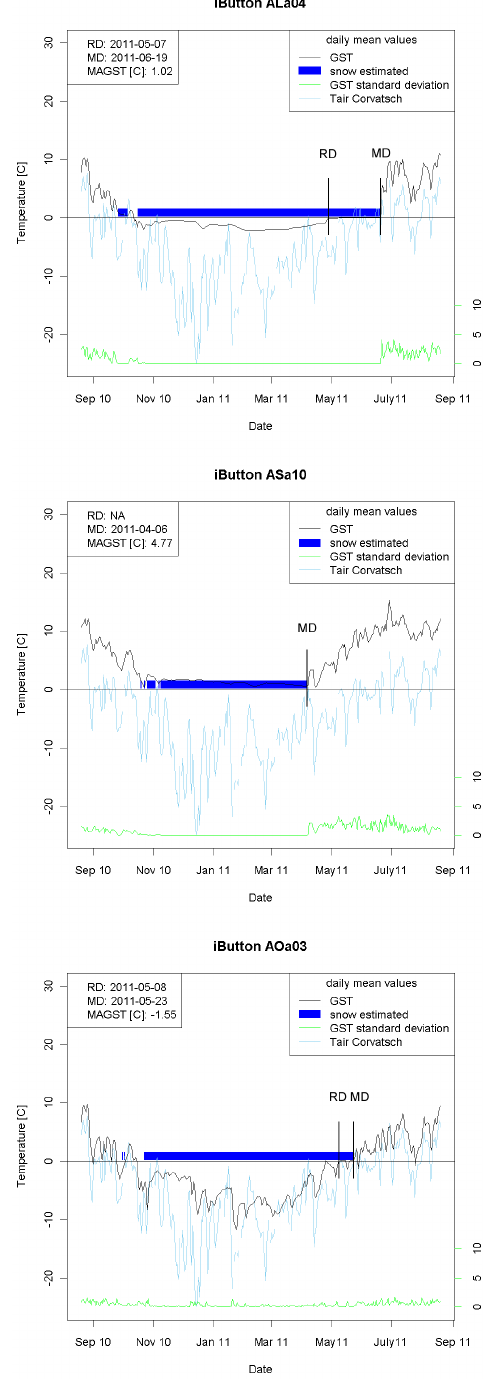
Fig. 5. Typical examples of temperature evolution. For all three iButtons an insulating snow cover is present. For ALa10, RD and MD are detected, whereas for ASa10, only MD can be detected. At AOa03, MD and RD were detected as well, but with a mean stan- dard deviation of the GST (Jan–Mar) of 0.19, it is the location with the highest value where we still predict an insulation snow